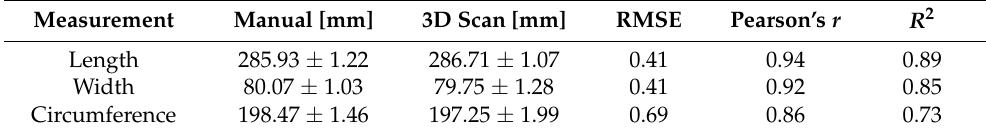
Linear relationships between manual and 3D scan results for three key hand anthropo- metric data with R 2 coefficients are presented in Figure 4.